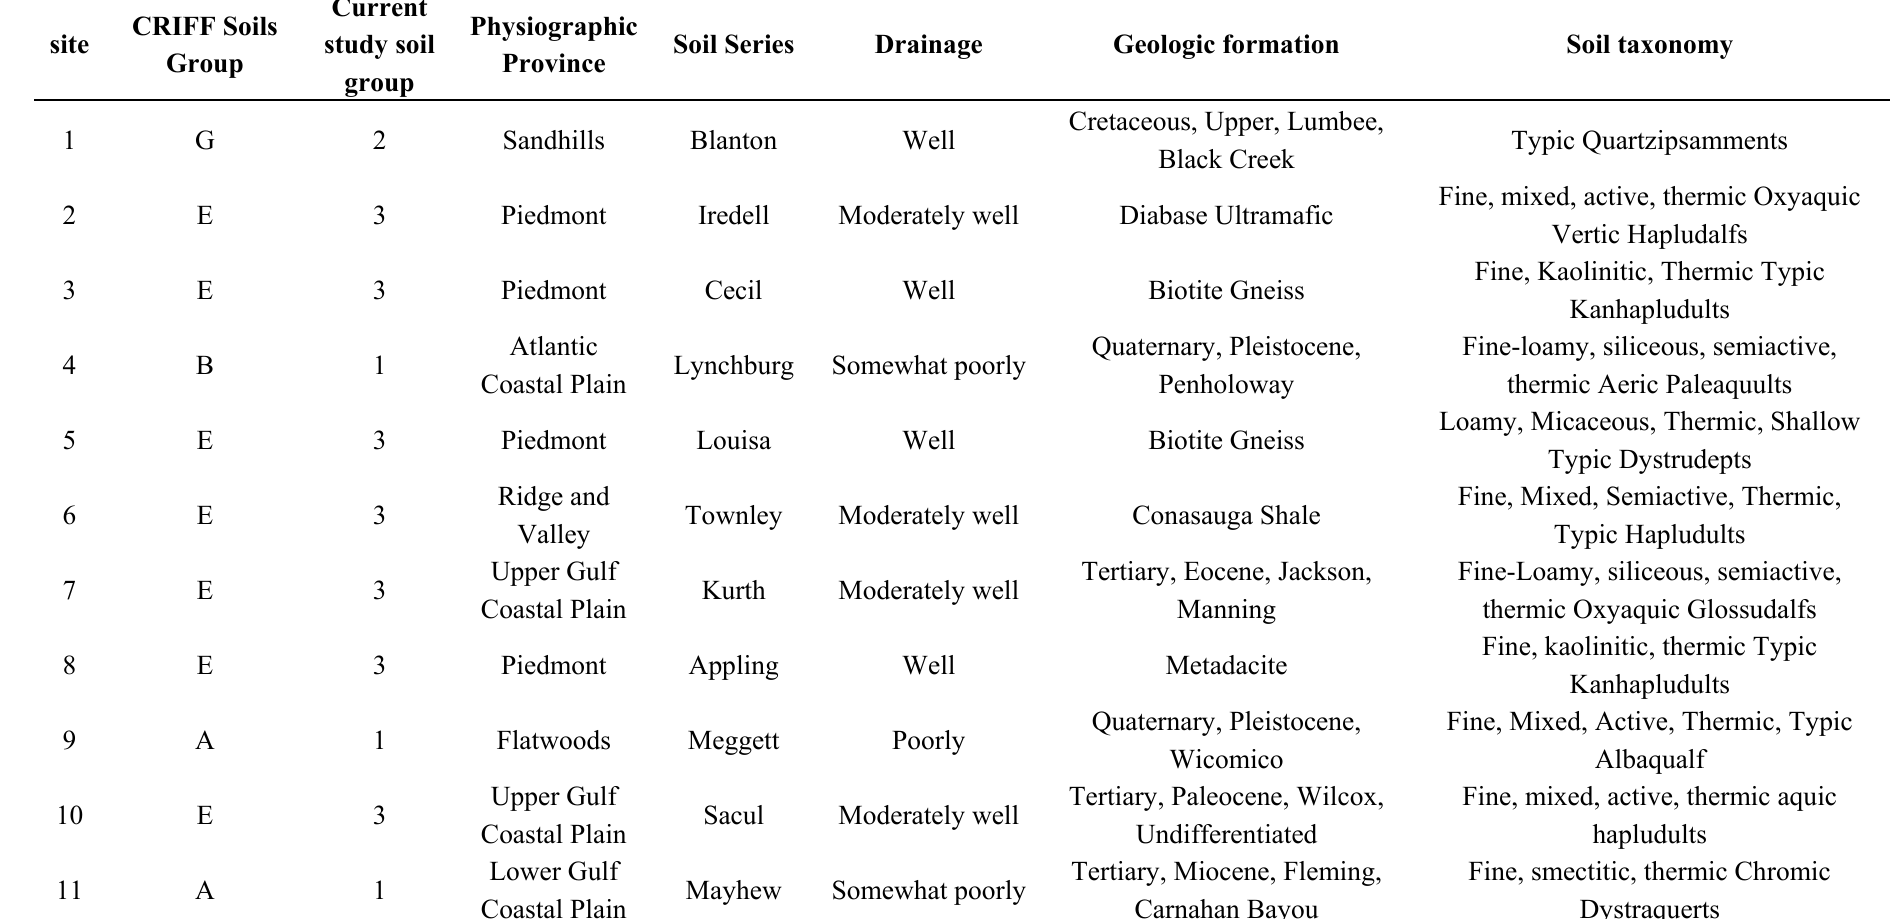
Table 2. Soils, physiography and geology for the sites examined in this study. Cooperative Research in Forest Fertilization (CRIFF) program soils groups are based on drainage and subsurface texture where groups A and B are poorly drained with clay subsurface, C and G are poorly to well drained with no clay in the subsurface and E and F are well drained with a clay subsurface. The current study soil group combines CRIFF A and B soils (current study group 1), CRIFF C and G soils (current study group 2) and CRIFF E and F soils (current study group